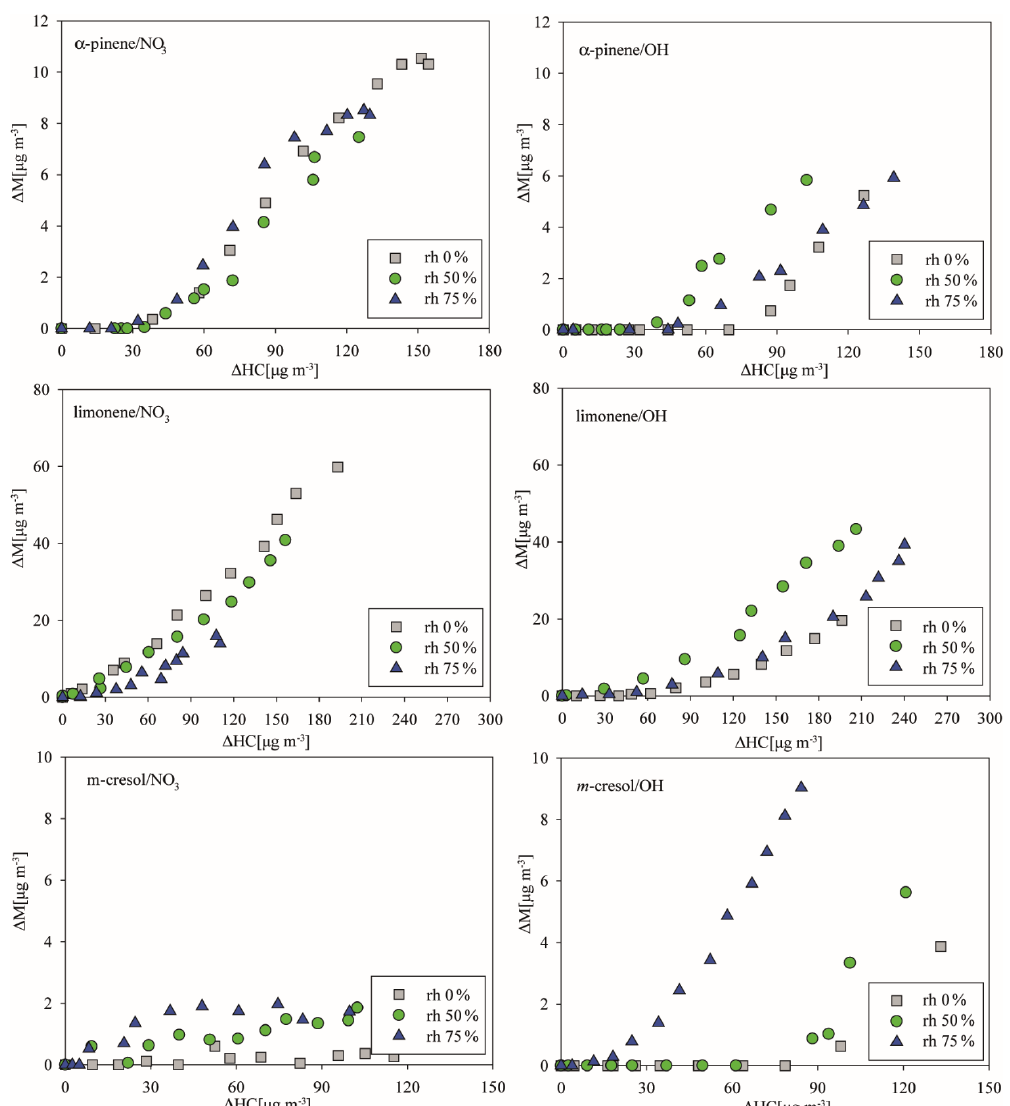
Figure 2. Growth curves for α -pinene, limonene, and m -cresol with NO 3 and OH radicals for 0, 50, and 75%